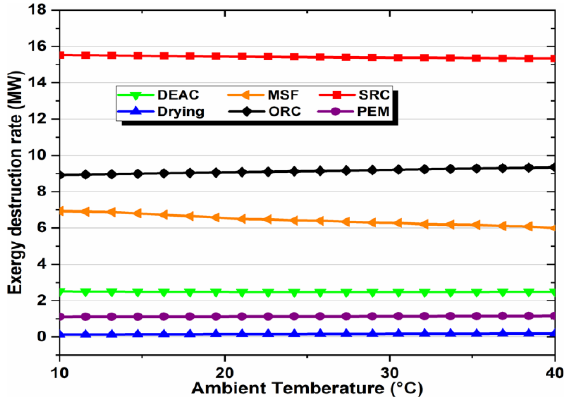
Figure 9. Effect of ambient temperature on exergy destruction rates of subsystems.